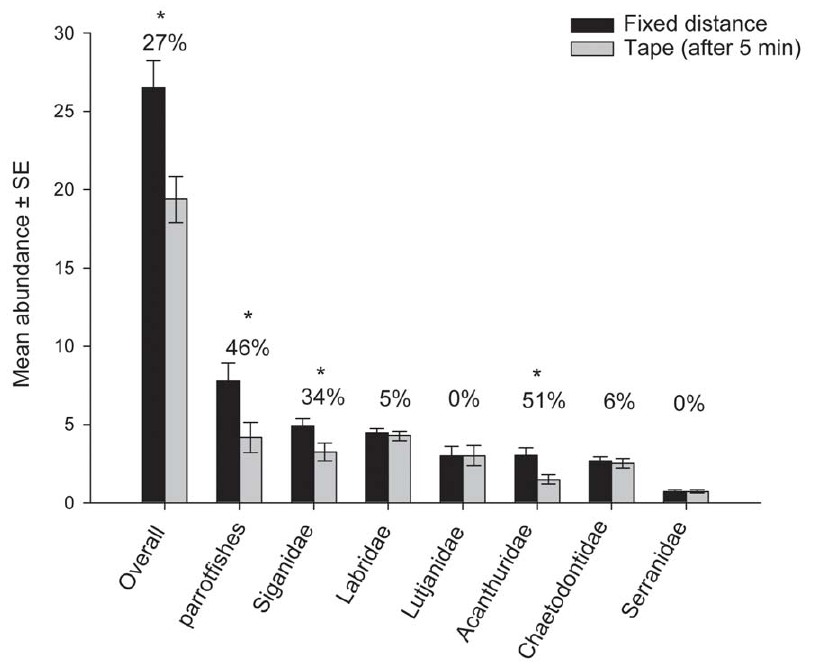
Figure 2. Relative diver effects – fixed distance and 5 minute waiting period. Relative diver effects on estimated reef fish densities comparing counts over a fixed distance 50 m transect and counts after a 5 minute waiting period. Values indicate the proportional decrease in abundance, asterisks represent significant differences using a Bonferroni corrected alpha-value ( p , 0.006).